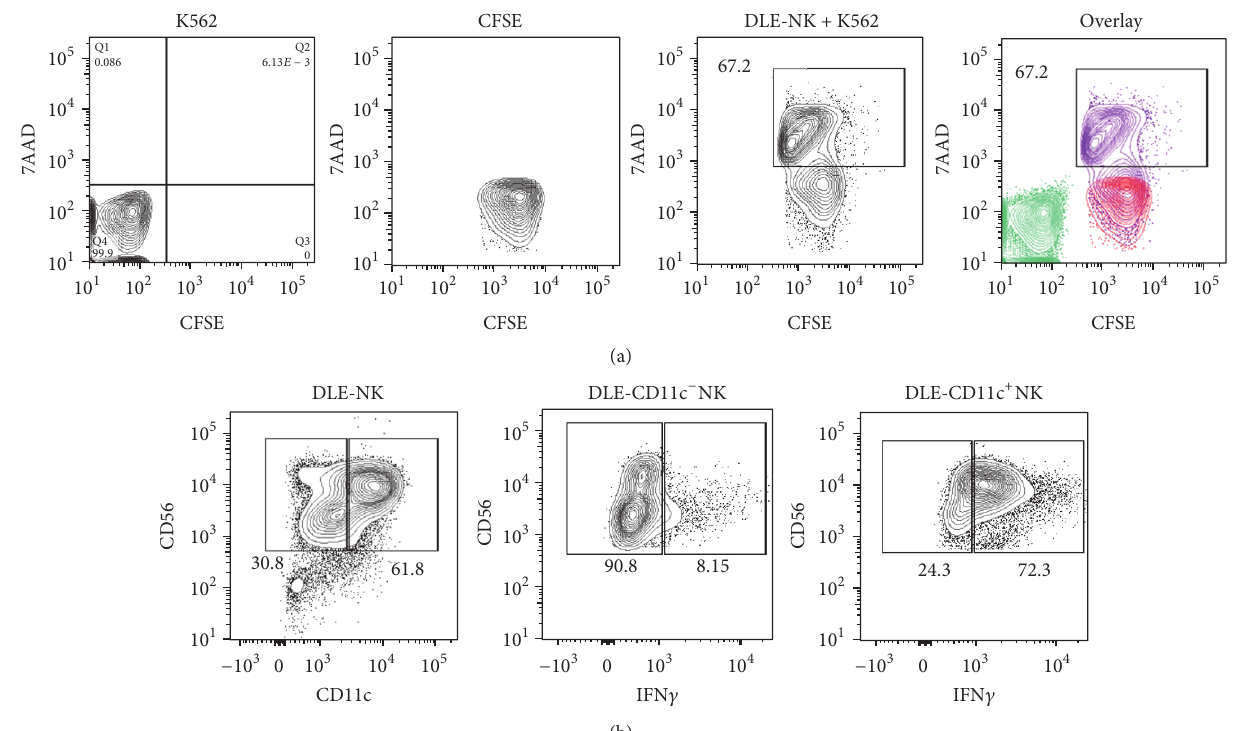
Figure 5: Effector functions of CD11c + NK cells differentiated from DLE-induced lymphoid progenitor cells include tumor cytotoxicity and IFN-gamma production. NK cytotoxicity function was evaluated on CFSE+ K562 tumor cells as target of NK-like cells derived from DLE stimulation (DLE-NK) (a). We used 7-aminoactinomycin D (7-AAD) to evidence the frequency of CFSE + 7-AAD + killed target cells. Production of IFN-gamma by CD11c − CD56 + and CD11c + CD56 + NK cells was detected by intracellular staining